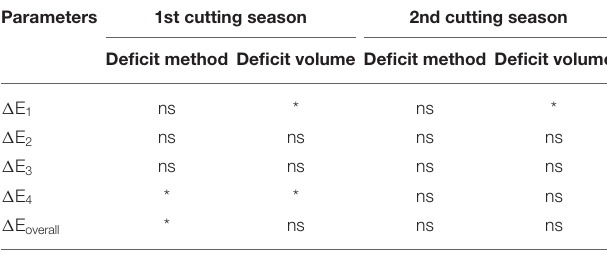
TABLE 3 | Evaluation of the effect of the deficit method and deficit volume on improvement of efficiency in an essential oil production process in cutting seasons 1 and 2 compared to FI.